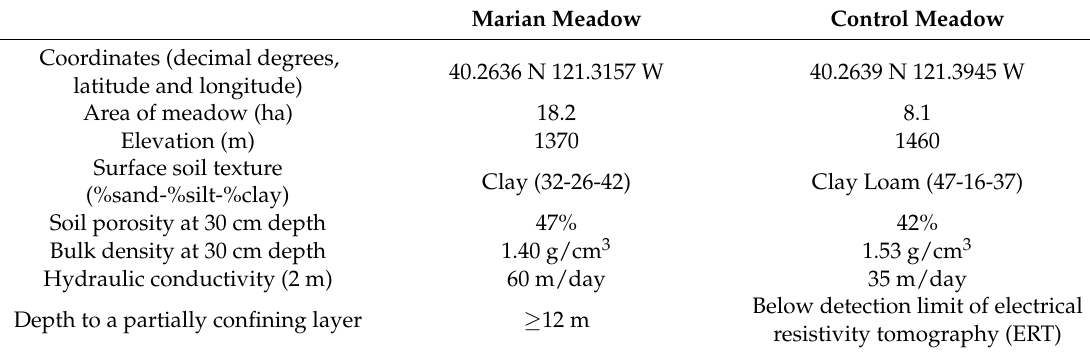
Table 1. Characteristics of Marian Meadow and Control